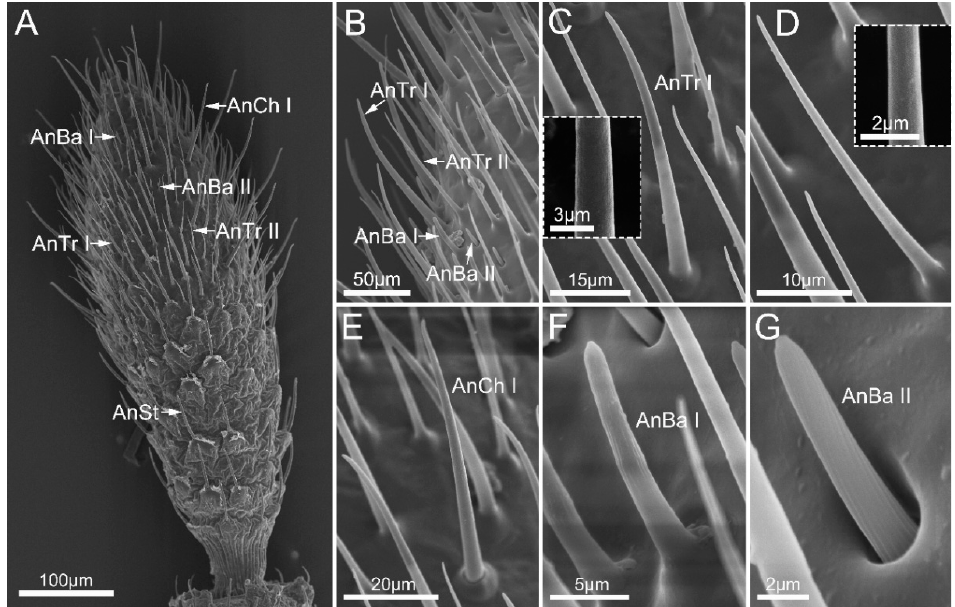
Figure 3. The second segment of flagellum of Mezira yunnana . ( A ) View of the second segment of flagellum; ( B ) enlarged view showing the distribution of the sensilla on the second segment of flagellum. ( C ) antennal sensilla trichodea I (AnTr I), with porous wall shown in the box; ( D ) antennal sensilla trichodea II (AnTr II), with porous wall shown in the box; ( E ) antennal sensilla chaetica I (AnCh I); ( F ) antennal sensilla basiconica I (AnBa I); ( G ) antennal sensilla basiconica II (AnBa II). Table 2. Morphometric data of antennal and labial sensilla in Mezira yunnana (mean ± SE). Type